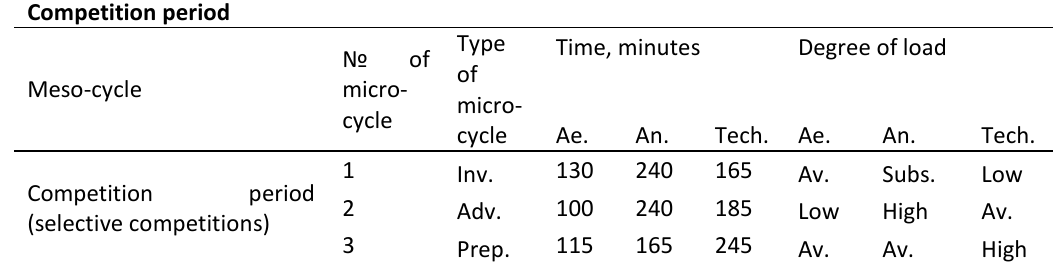
Table 4. Time of exercises and loads of different character for EG in competition